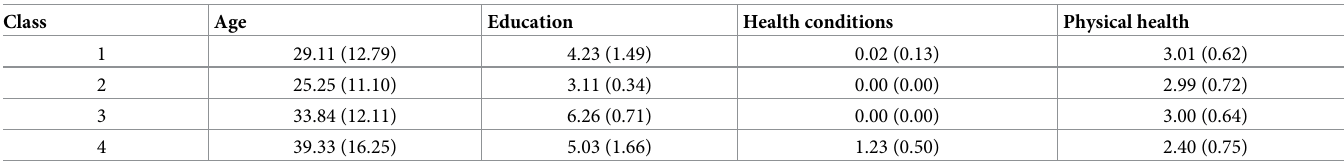
Fig 1A and 1B present mean scores on the 14 variables included in LPA. Demographic and health characteristics for each Class are summarised in Table 3. Mean levels on the demo- graphic variables were distinct for the four classes. Class 1 had the lowest mean scores on the measures related to COVID-19, including avoidant, preventive, and management of illness behaviours, self-reported compliance, worry about COVID-19, perceived benefits, response efficacy, and perceived barriers beliefs (reverse-coded for ease of graphical representation). Thus, this group appeared to be non-compliant with recommendations. Classes 2, 3, and 4 did not differ from each other on the COVID-19 measures and appeared to be compliant with rec- ommendations. For prosocial behaviours, Class 1 was slightly higher than Class 2 but did not differ from Classes 3 or 4. There were no other differences between classes on pro- and anti- social behaviours. Class 1 members are relatively young individuals (M = 29.1, SD = 12.8), cur- rently with relatively low levels of education (average highest attainment being vocational/ trade certificate), good physical health, and no pre-existing health conditions. Similar to Class 1, members of Class 2 are young, and indeed the youngest of the sample (M = 25.2, SD = 11.1), with good physical health, no pre-existing health conditions, and major- ity currently at university (54% in this group were recruited from the University pool; majority [87%] reported high school as their highest educational attainment). Dissimilar to Class 1, this group of young people scored higher on COVID-19 measures, indicating compliance. Classes 3 and 4 were also compliant with protective behaviours. Class 3 were approaching middle age (M = 33.8, SD = 12.1), had the highest level of education (average highest attain- ment being bachelor’s degree), good physical health, and no pre-existing health conditions. Table 3. Mean demographic and health information for each